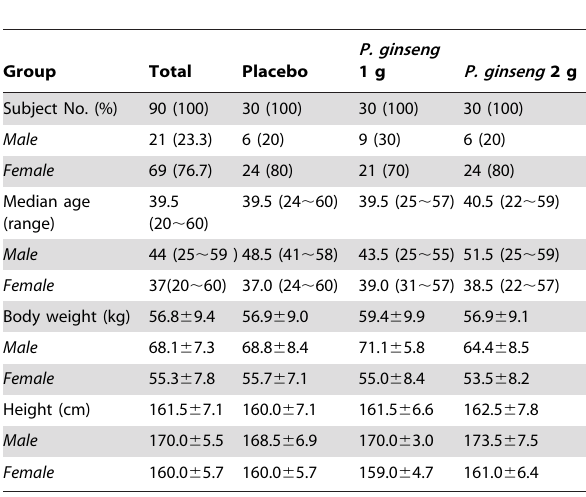
Table 1. Physical baseline characters of